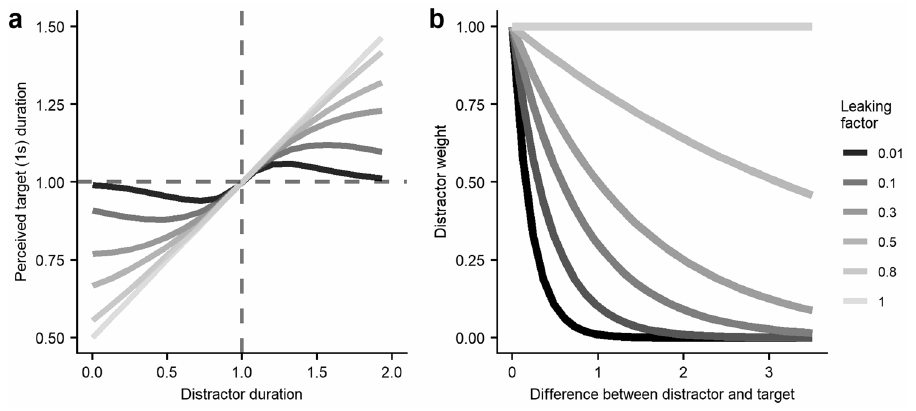
Figure 2. ( a ) Perceived duration of a 1 s target as a function of the duration of simultaneous distractors. ( b ) Weight of the distractors as a function of their difference with the target duration. Each line represents a different value of the leaking factor